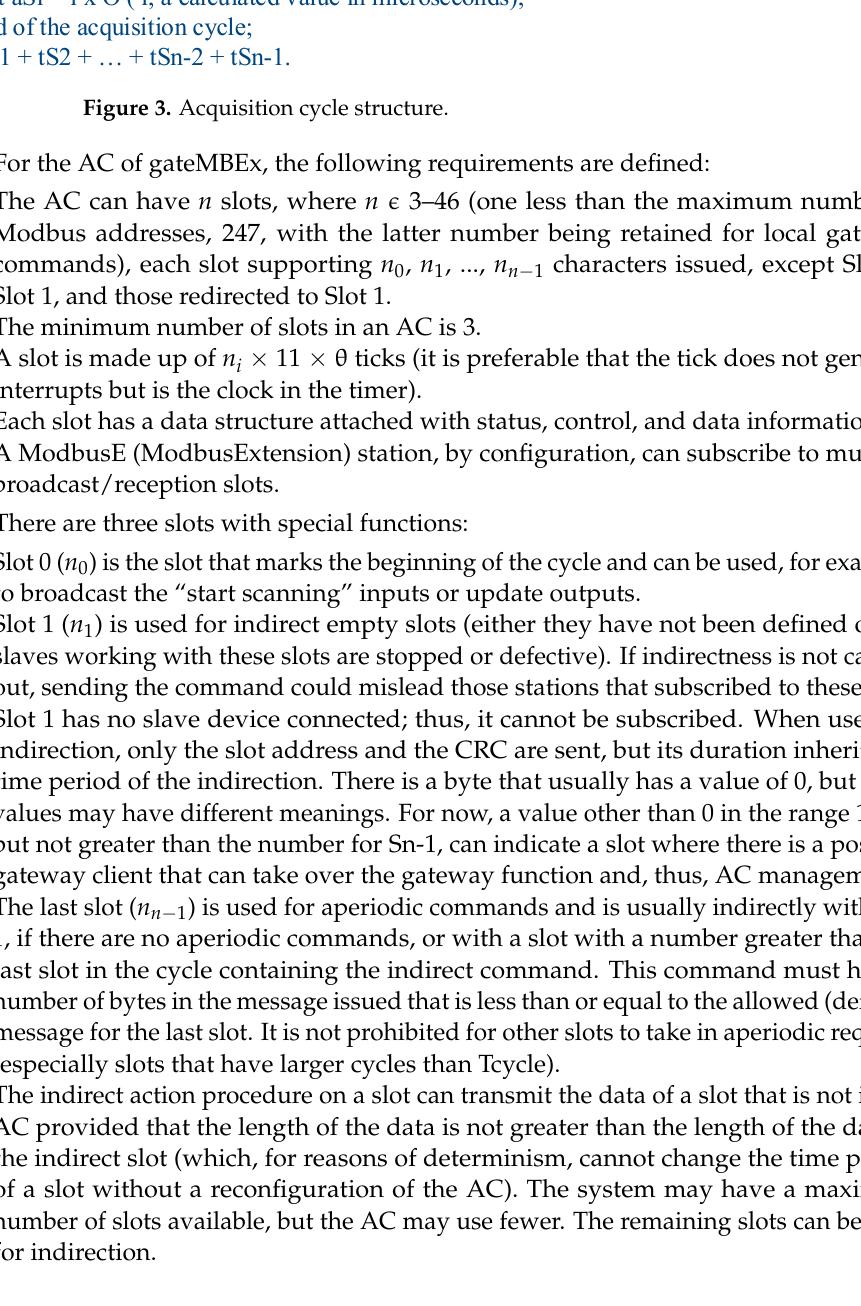
Figure 3. Acquisition cycle structure.